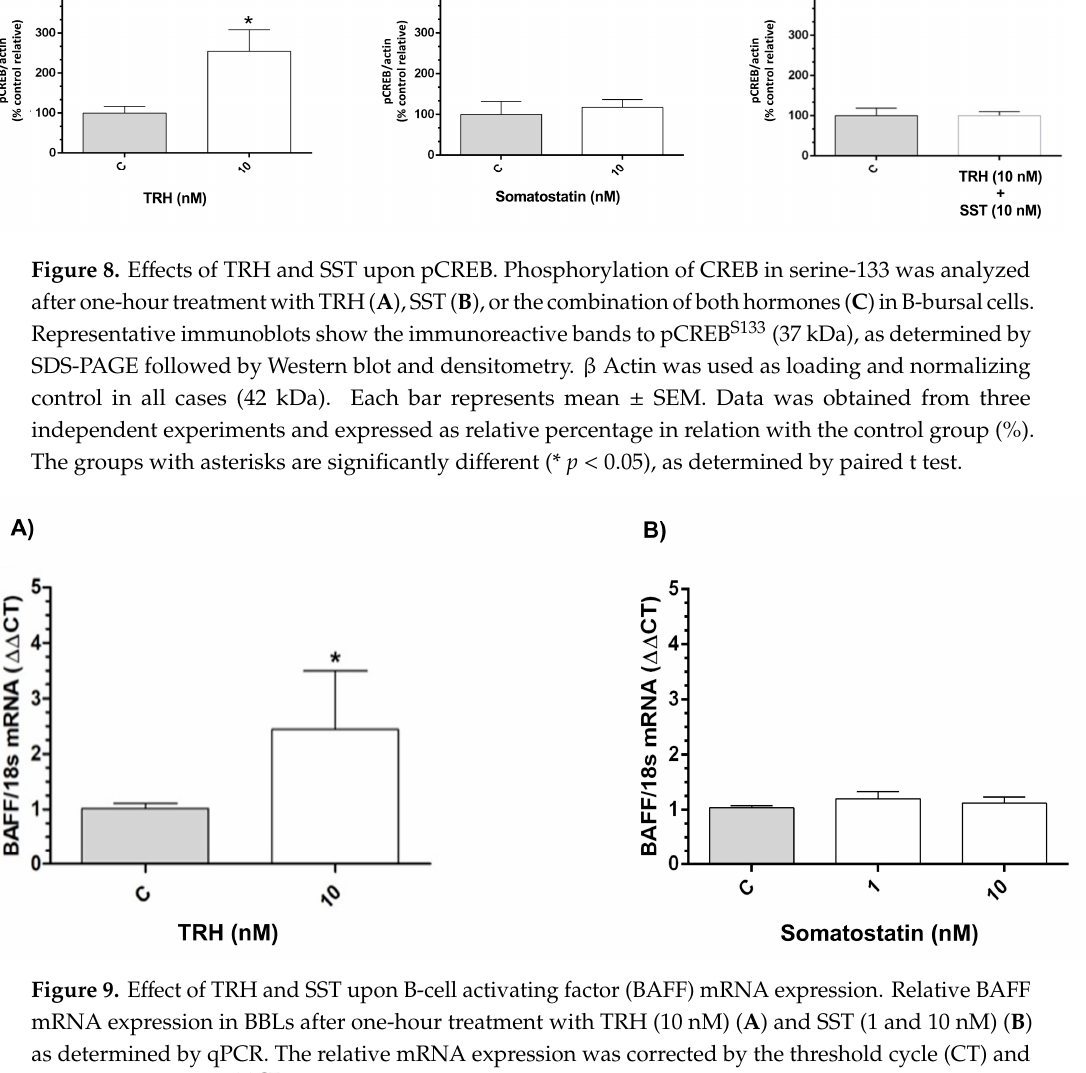
Figure 9. Effect of TRH and SST upon B-cell activating factor (BAFF) mRNA expression. Relative BAFF mRNA expression in BBLs after one-hour treatment with TRH (10 nM) ( A ) and SST (1 and 10 nM) ( B ) as determined by qPCR. The relative mRNA expression was corrected by the threshold cycle (CT) and using the formula 2 −ΔΔ CT [29,30]. Ribosomal 18S RNA was used as reference gene. Each bar represents means fold ± SEM. Data were obtained from three independent experiments analyzed by duplicate. Asterisks indicate significant differences when compared with control groups (* p < 0.05), as determined by unpaired t test.